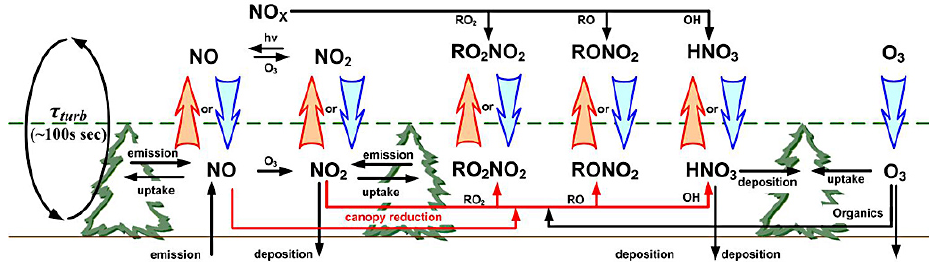
Figure 12. Schematic of the interactions involved in the exchange of nitrogen oxides between the atmosphere and the forest canopy as identified in this manuscript. Bold arrows in blue (downward) and red (upward) represent the direction of the flux of each species across the canopy surface. Red thin arrows within canopy indicate the NO x removal processes within the canopy in addition to plant uptake.